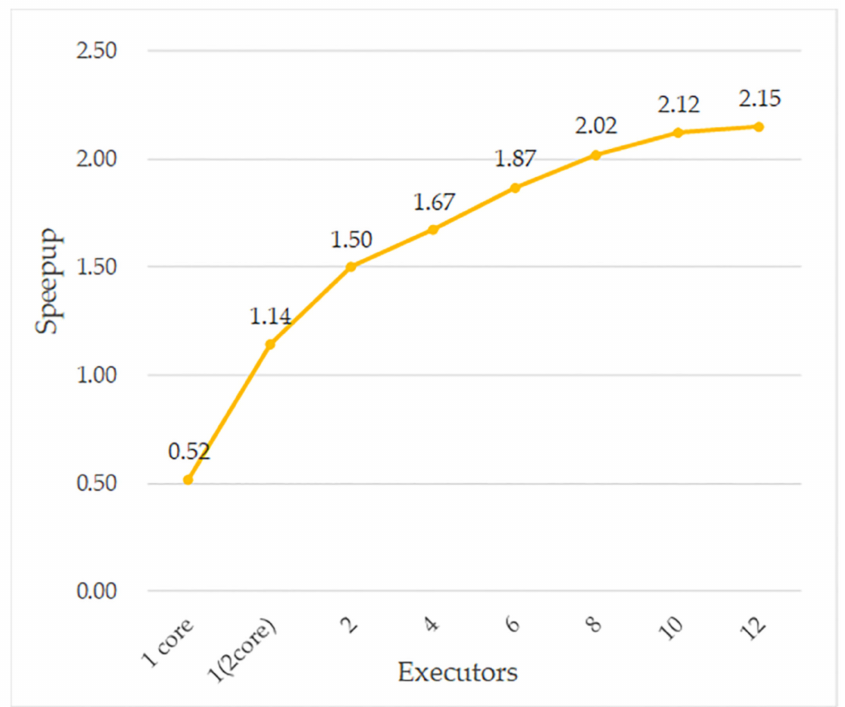
Figure 12. Number of executors versus speedup ratio for the case of three nodes: the x -axis represents the number of executors, where the first value indicates that one executor is started in the case of a single core, and the remaining values start 2 cores. The y -axis represents the